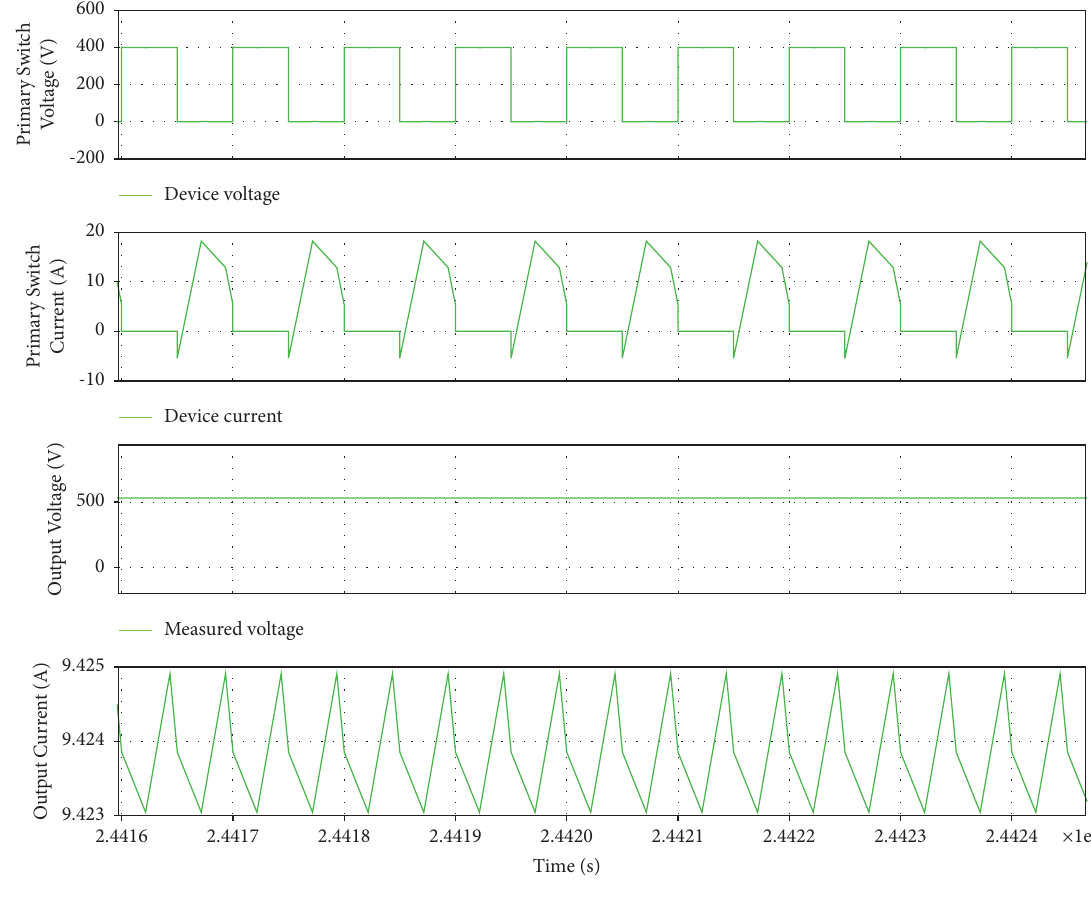
Figure 14: Simulated waveforms of the converter with trench SiC